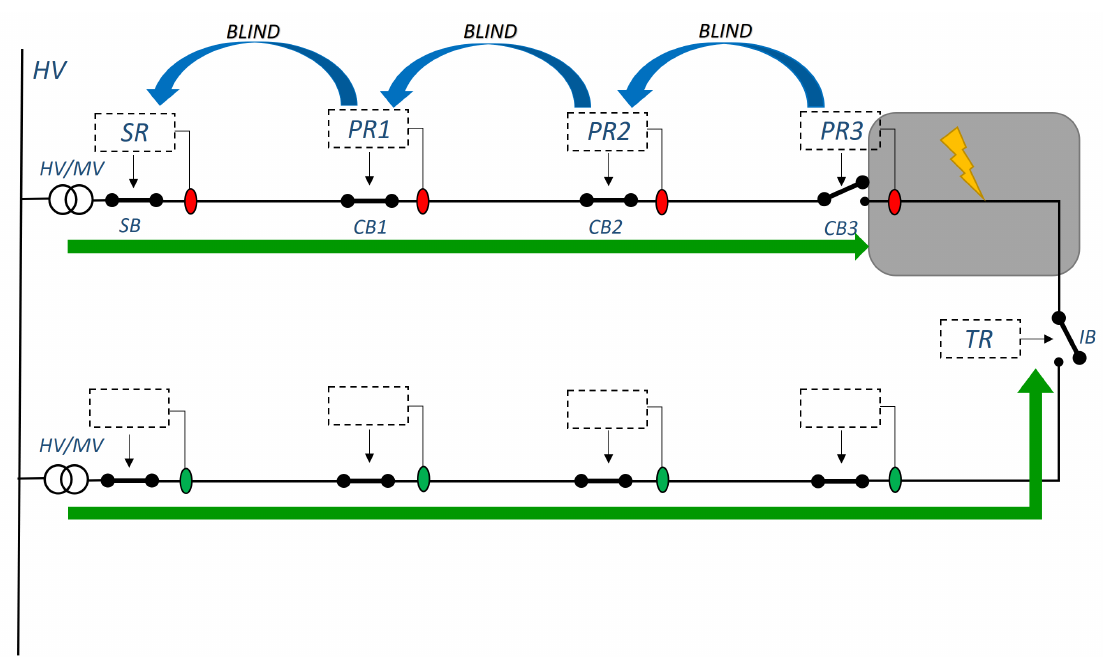
Figure 19. Messages exchange during a fault 50.S3 between PR3 and TR.